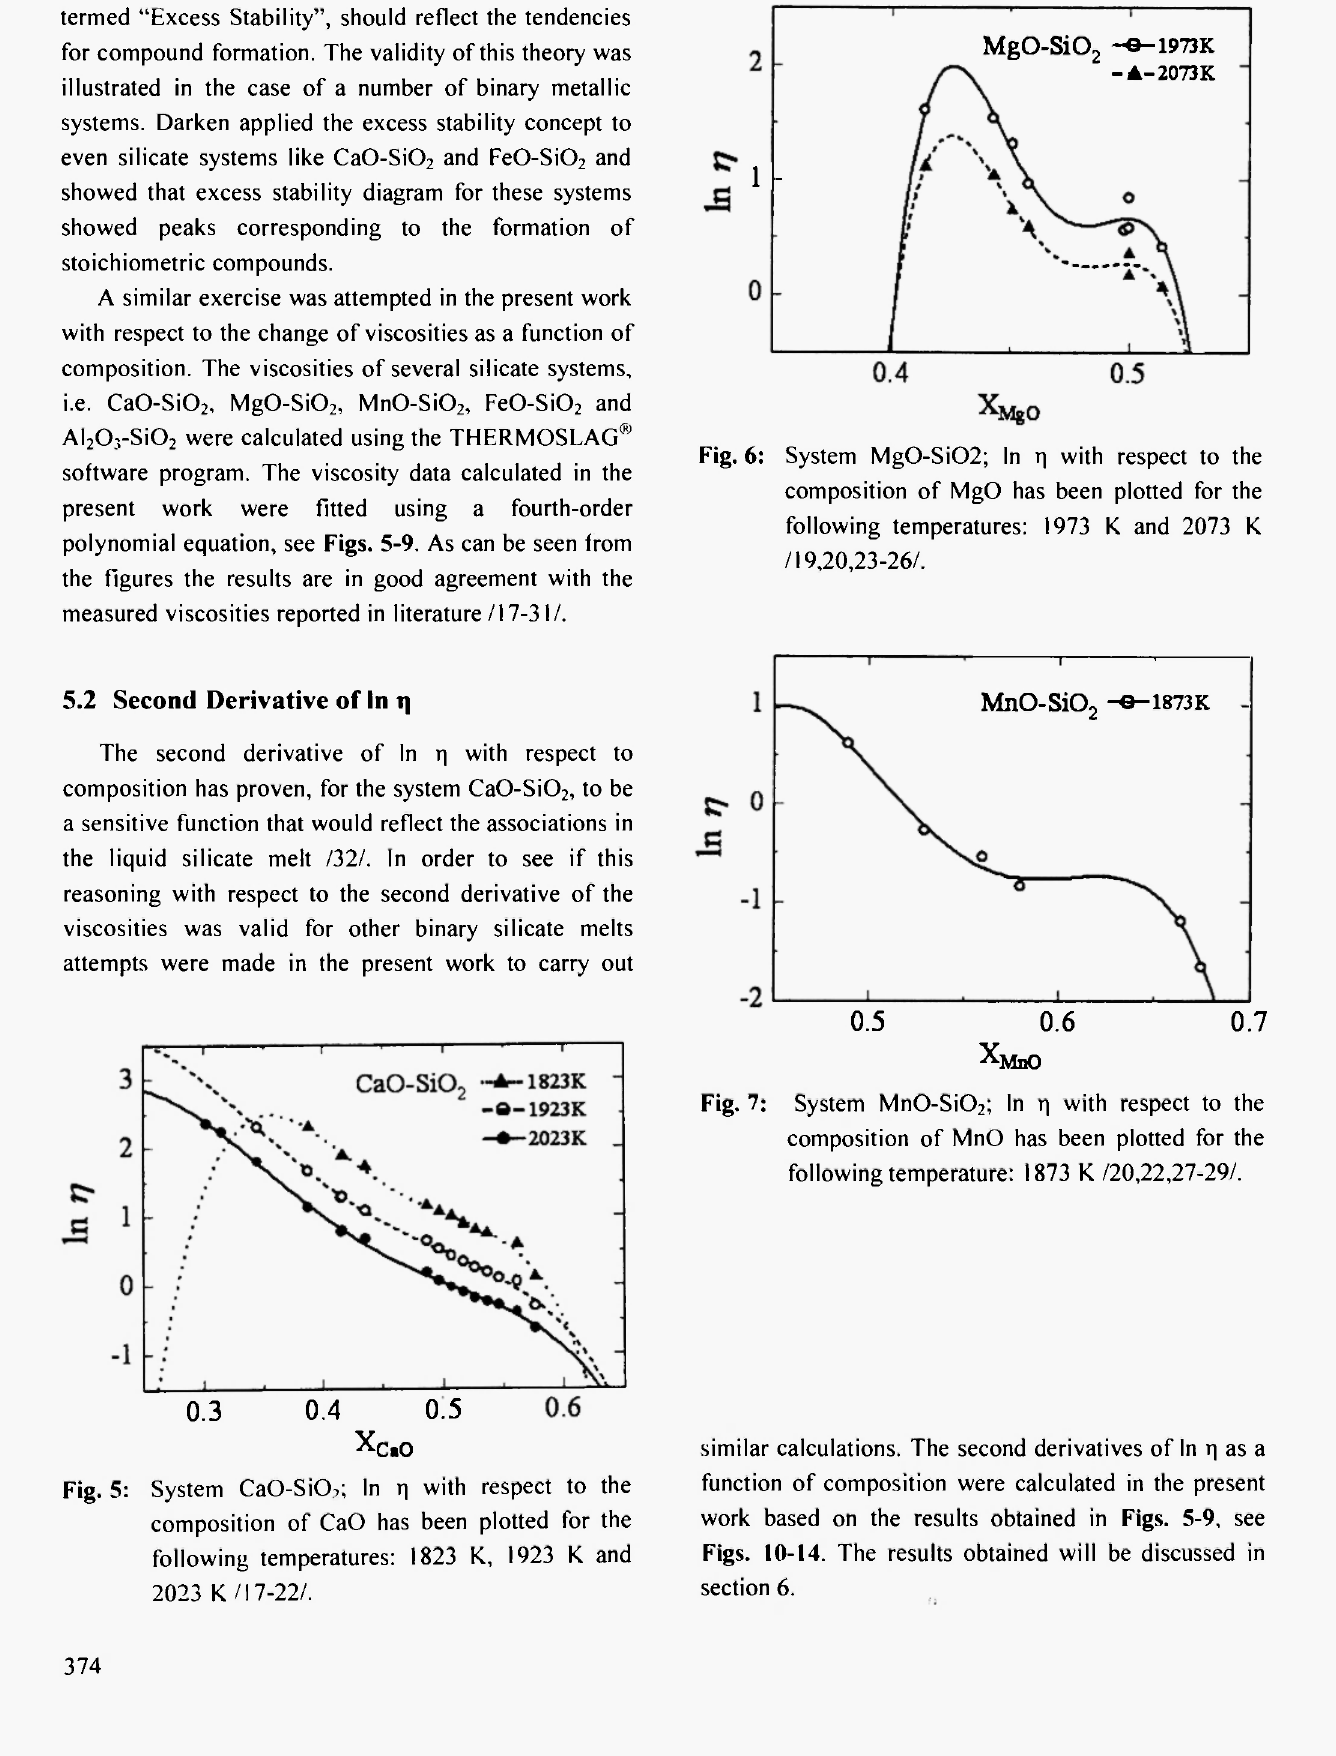
-Θ-1973Κ 2 -A-2073 Κ